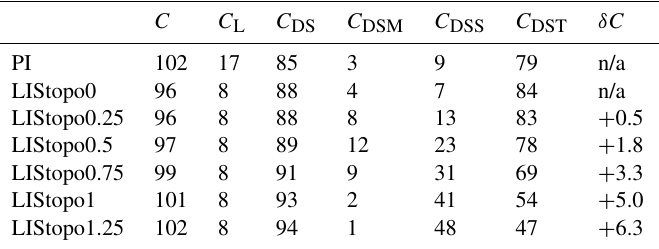
Figure 3. Vertically and zonally integrated (annual-mean) atmospheric northward flux (PW = 10 15 W) of (a) total energy ( F ), (b) latent energy ( F L ), and (c) dry-static energy ( F DS ) and dry-static energy contributions from the (d) mean circulation ( F DSM ), (e) stationary eddies ( F DSS ), and (f) transient eddies ( F DST ). Table 1. The atmospheric flux convergence (Wm − 2 ) in the Arctic (area-weighted average > 70 ◦ N) separated into total energy ( C ), latent energy ( C L ), and dry-static energy ( C DS ). The latter is further decomposed into contributions from the mean circulation ( C DSM ), stationary eddies ( C DSS ), and transient eddies ( C DST ). δC shows the change in the total energy-flux convergence with respect to